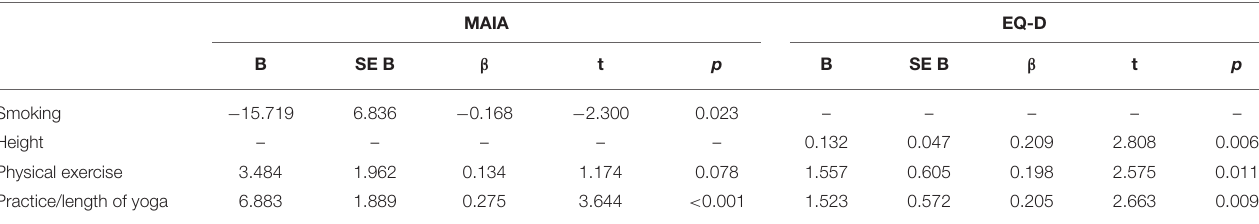
TABLE 7 | Hierarchical regression analysis with practice of yoga and perseverance in it as the predictor variable in total MAIA and EQ-D scores of the Indian participants after controlling sociodemographic characteristics, life habits, and aspects of yoga practice. MAIA EQ-D SE B